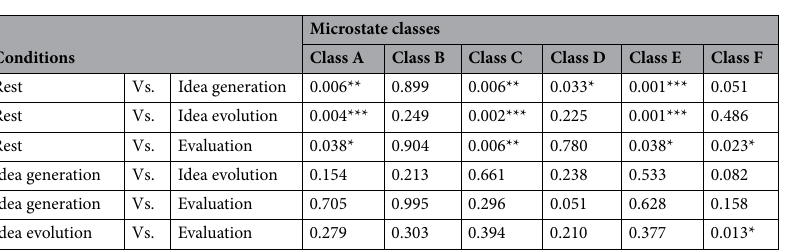
Table 4. Paired t-test p-values for microstate duration between conditions. * ρ < 0.050 , ** ρ < 0.010 , *** ρ <